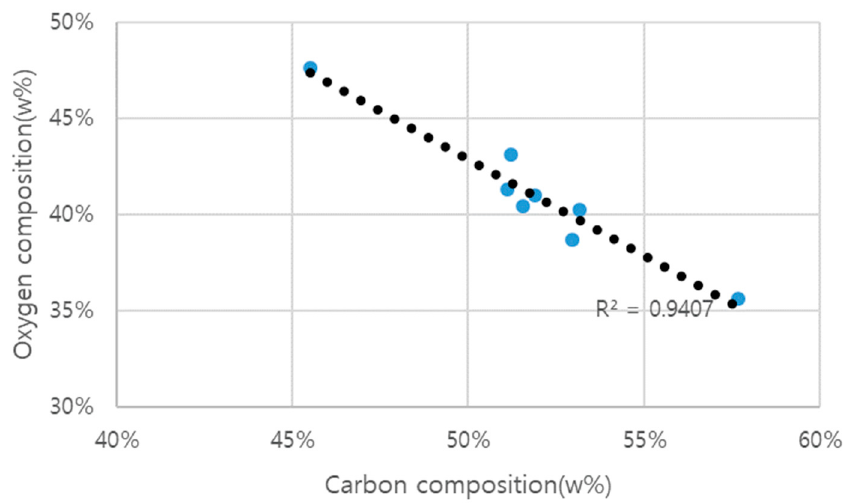
Figure 1. Relation between carbon and oxygen content in biomasses at dry ash free condition.